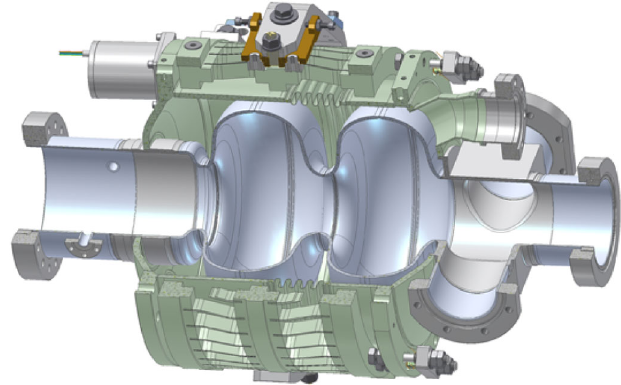
FIG. 4. Section view of a CAD model of a Cornell ERL injector cavity.